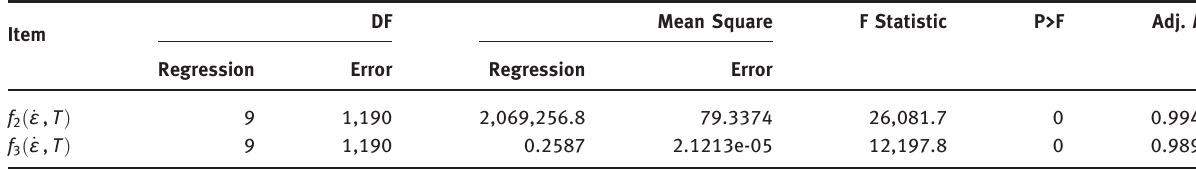
Table 8: Analysis of variance for f 2 ð _ ε , T Þ and f 3 ð _ ε , T Þ at medium temperature region. DF Mean Square Item